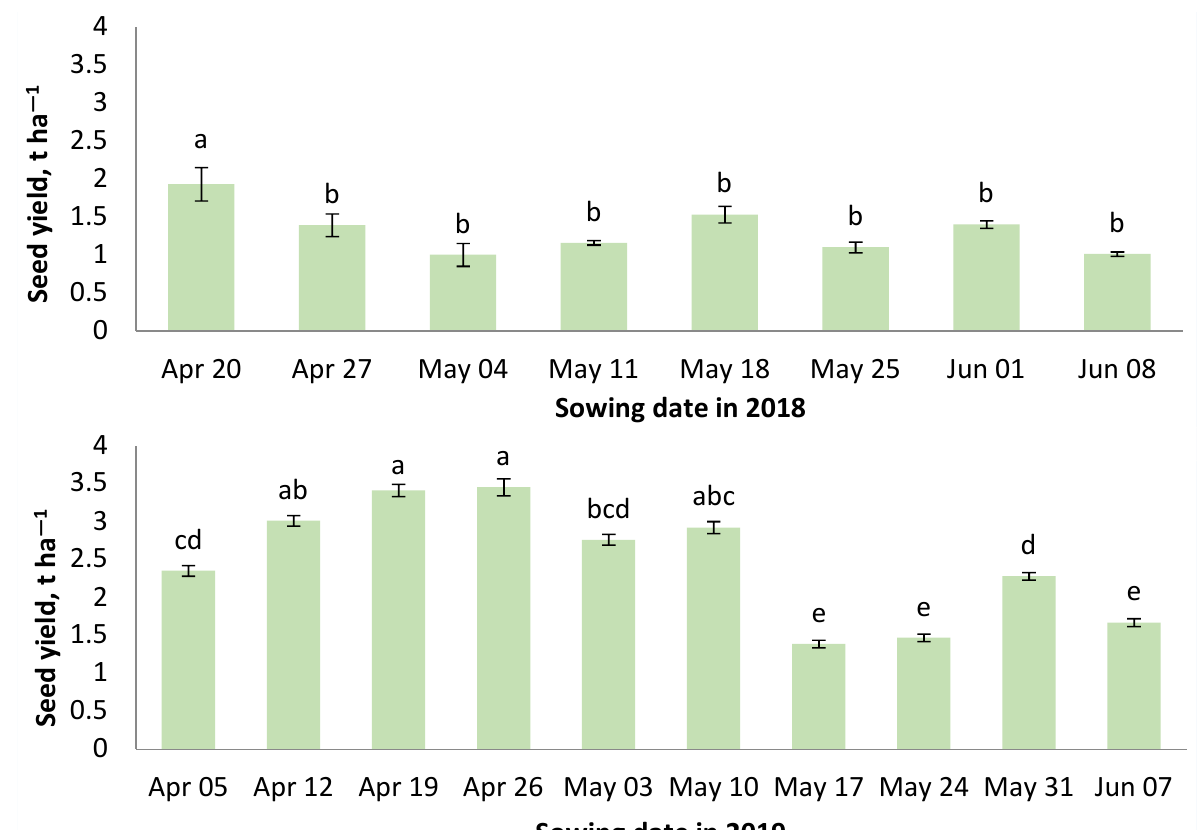
Figure 2. The influence of sowing time on spring rapeseed yield in 2018 and 2019. Differences between the means of the variants marked with different letters (a, b, ...) are significant ( p ≤ 0.05); bars indicate standard error of the mean (SEM).